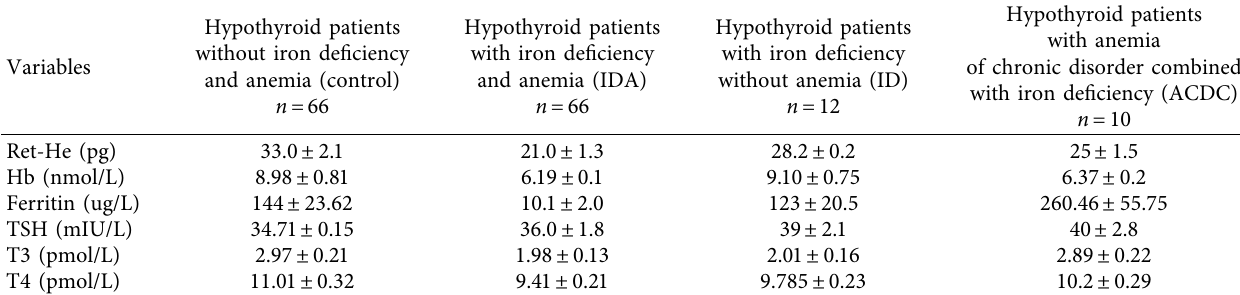
Table 1: Biochemical parameters and thyroid profile in hypothyroid patients with IDA, ACDC, ID, and control.